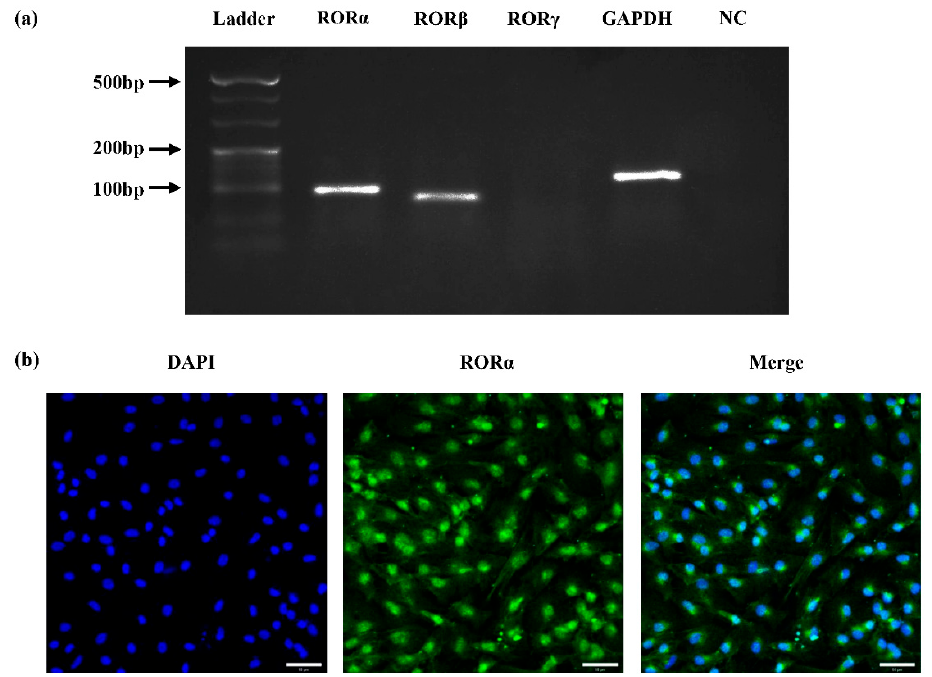
Figure 1. Expression of nuclear receptor retinoid acid receptor-related orphan receptors (RORs) in rat dental papilla cells (rDPCs). ( a ) Total RNA was extracted from rDPCs and detected by reverse transcription polymerase chain reaction (RT-PCR) and agarose gel electrophoresis assay using specific primers for ROR α , ROR β , ROR γ , and glyceraldehyde-3-phosphate dehydrogenase (GAPDH). RT-PCR without primers served as the negative control (NC); ( b ) Immunofluorescence staining was performed with polyclonal anti-ROR α antibody (green), and nuclei were labelled with 4-6-diamidino-2-phenylindole (DAPI, blue). Scale bar: 50 μ m.